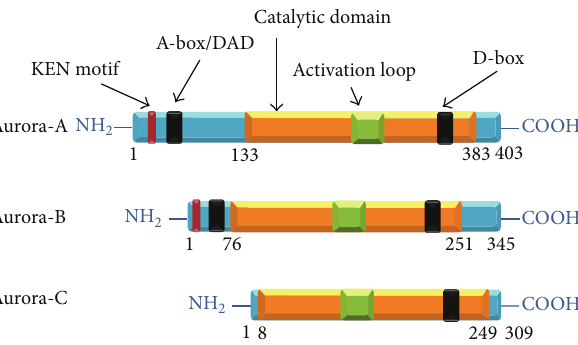
Figure 1: Schematic representation of Aurora kinase proteins. D- box, destruction box; DAD, D-box activating domain; KEN motif, amino acidic K-E-N which serves as targeting signal for the Cdh1- anaphase promoting